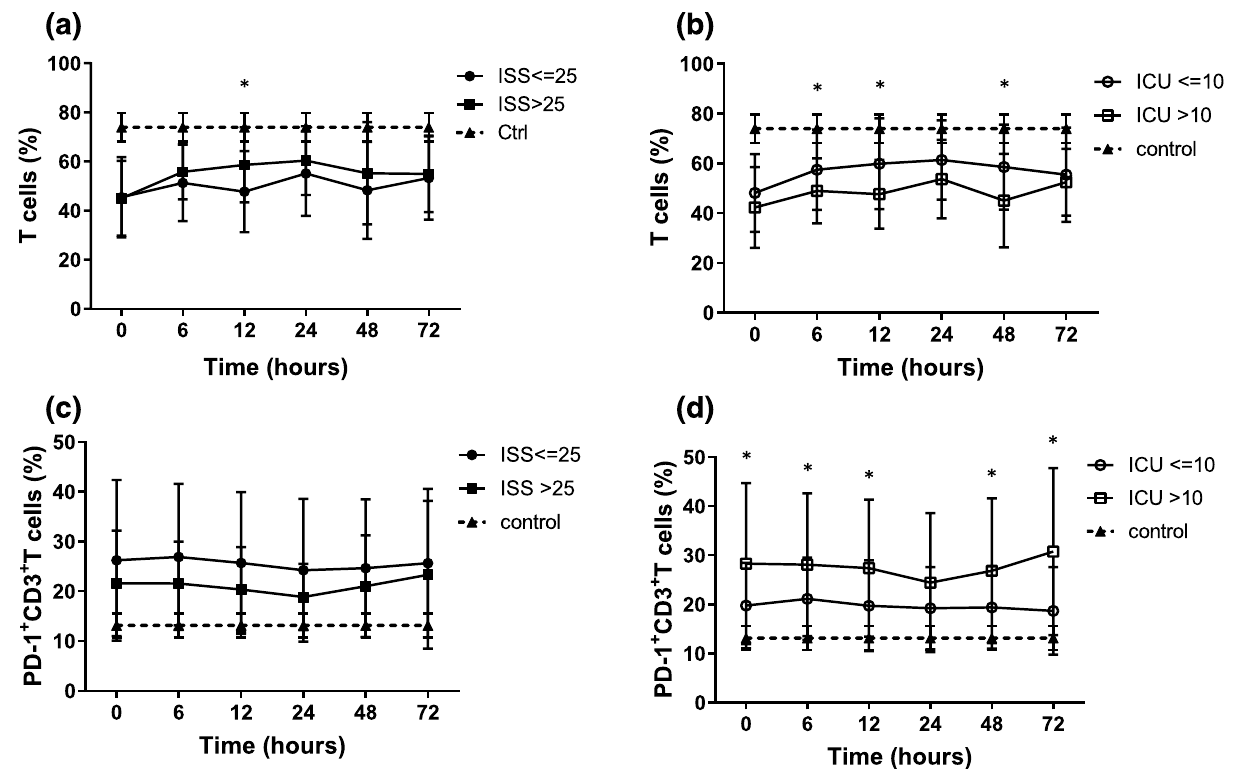
Figure 5. Trauma patients had suppressed T cells and increased expression of PD-1 on T cells compared to control group. ( a ) T cells in trauma patients grouped by ISS. ( b ) T cells were significantly suppressed in the patients with a long ICU stay compared to those with a short ICU stay . ( c ) PD-1 expression on T cells in trauma patients grouped by ISS. ( d ) PD-1 expression on T cells was significantly increased in the patients with a long ICU stay compared to those with a short ICU stay, * p <